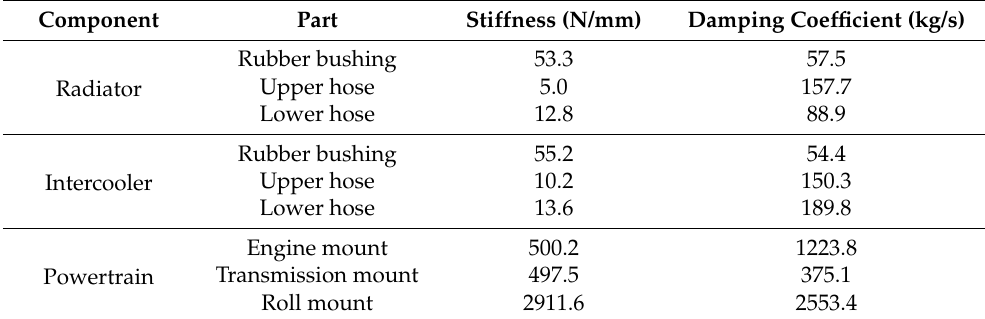
Table 2. Equivalent stiffnesses and damping coefficients of the bushings, hoses, and mounts at the idle frequency of 27.7 Hz.